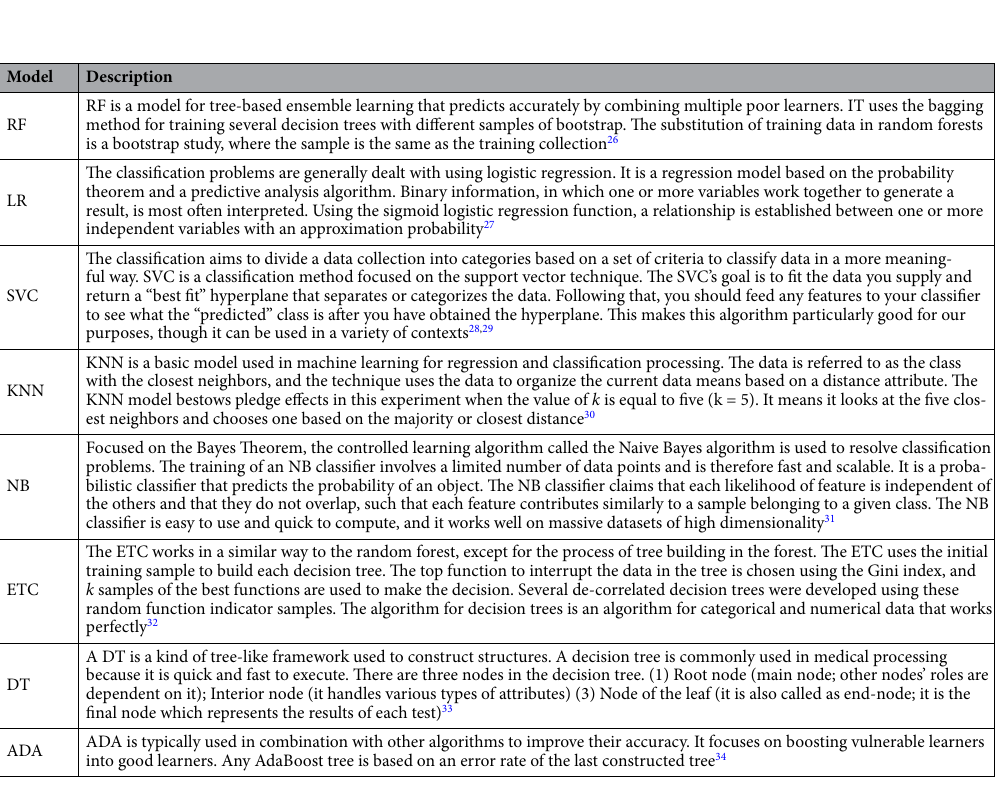
Table 10. Description of used machine learning